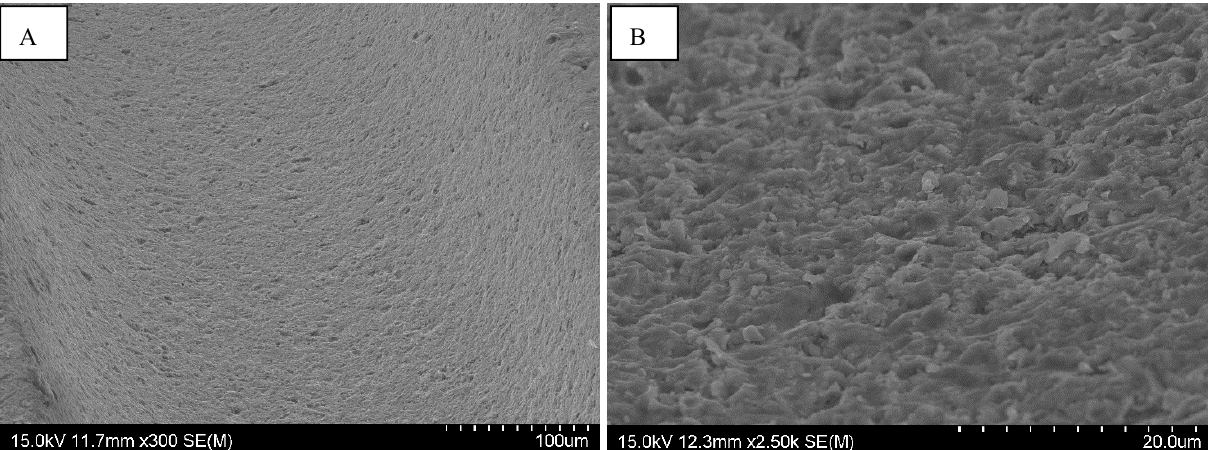
Figure 2. SEM image of the surface morphology of the Tekka Inkone ® implant showing a regular surface: magnification ×300 ( A ) and ×2500 ( B ).